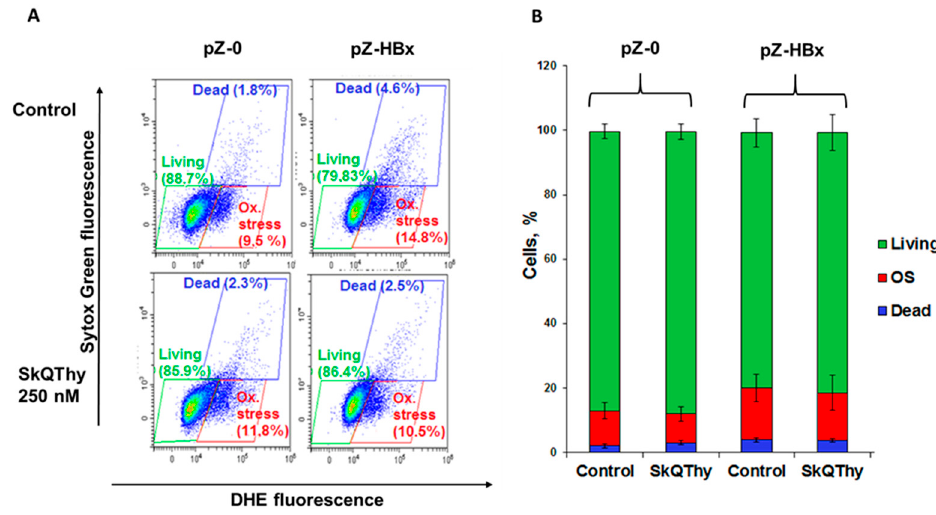
Figure 3. Oxidative stress and cell death in Y. lipolytica strains. Panel ( A )—flow cytometry measure- ment; Panel ( B )—the same results are presented in the form of histograms summarizing results from three independent experiments.